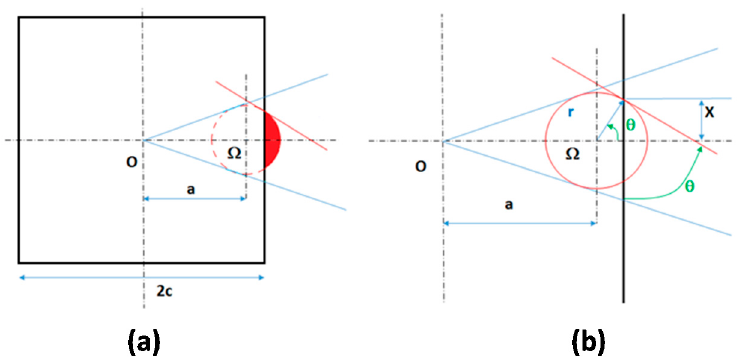
Figure 2. ( a ) Schematic illustration of cubic particles with the nucleus on one face, and ( b ) the detailed section of the formation of the nucleus from the face of a cubic particle.